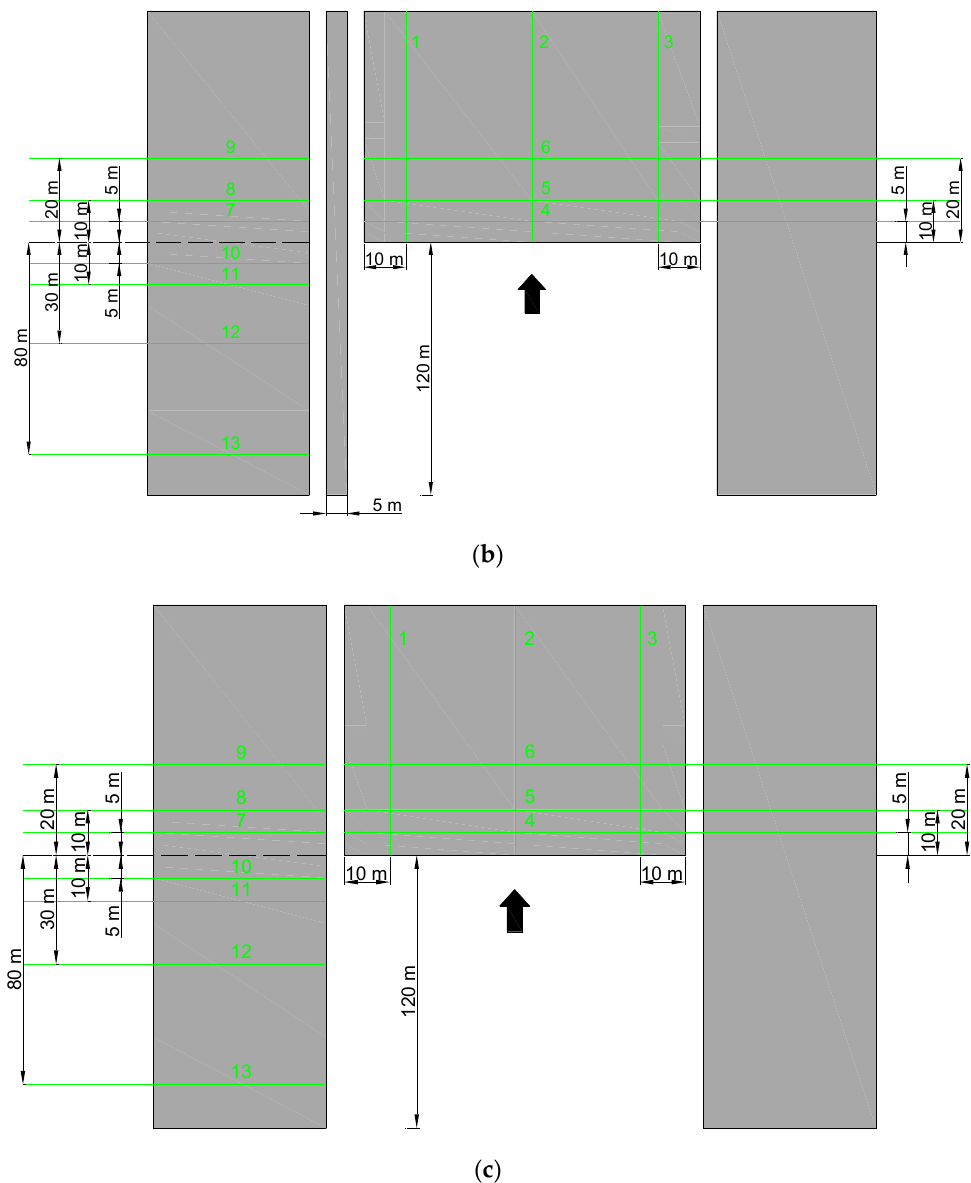
Figure 9. Location of monitoring lines. ( a ) Location of monitoring lines of large pillar mining; ( b ) Location of monitoring lines of small pillar mining; ( c ) Location of monitoring lines of non-pillar mining.